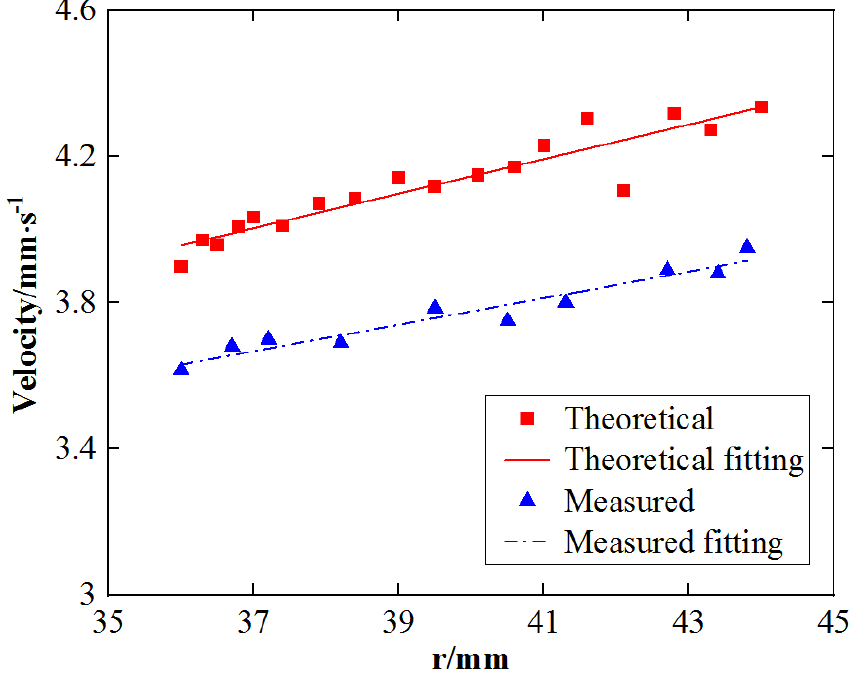
Figure 6. The measured velocity and the theoretical velocity of the droplet at different locations ( a = 1.061 rad/mm, n = 1000 rpm, D = 0.3 mm, µ o = 12.60 mPa · s). Model predictions were also experimentally verified over a range of speeds (600–1600